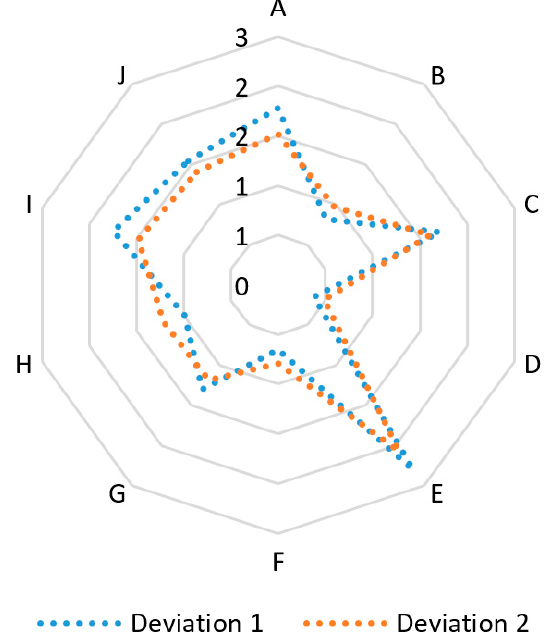
Figure 5. Deviations from the planned level of financial competitiveness before and after using the corporate decision-making model. Source: generated by the authors.